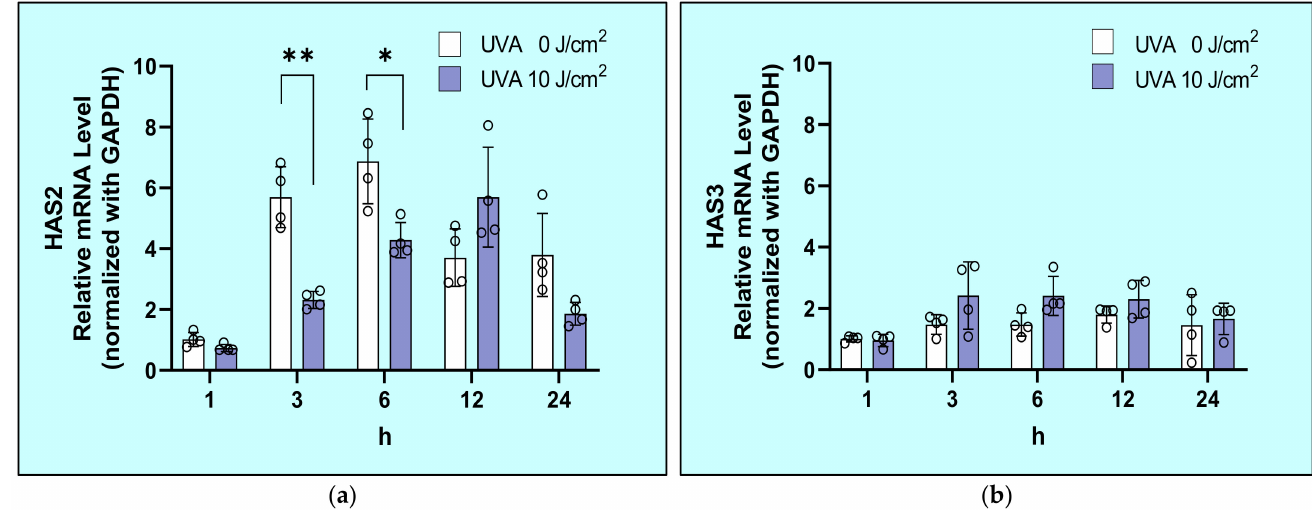
Figure 4. UVA specifically downregulates the transcription of HAS2 ( a ) but not HAS3 ( b ) in HDFs. After exposure to UVA at 0 or 10 J/cm 2 , HDFs were cultured in fetal bovine serum (DMEM) without fetal bovine serum (FBS). mRNA levels at the indicated times of culture were analyzed by Reverse transcription-quantitative polymerase chain reaction(RT-qPCR) as described in the Materials and Methods section. Values are means ± S.D. from four independent experiments. **: p < 0.01 vs. 0 J/cm 2 , *: p < 0.05 vs. 0 J/cm 2